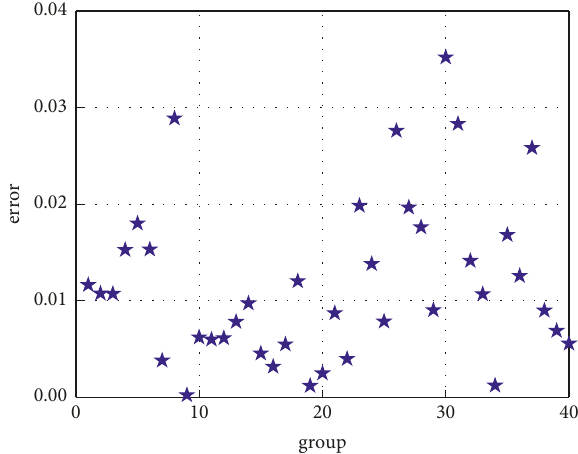
Figure 6: The prediction error distribution of Hanfu shape